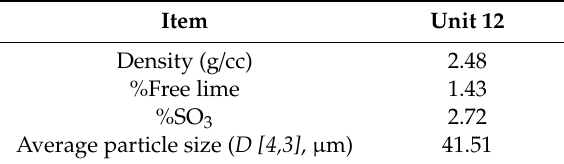
Table 1. General characteristic properties of the fly ash sample.